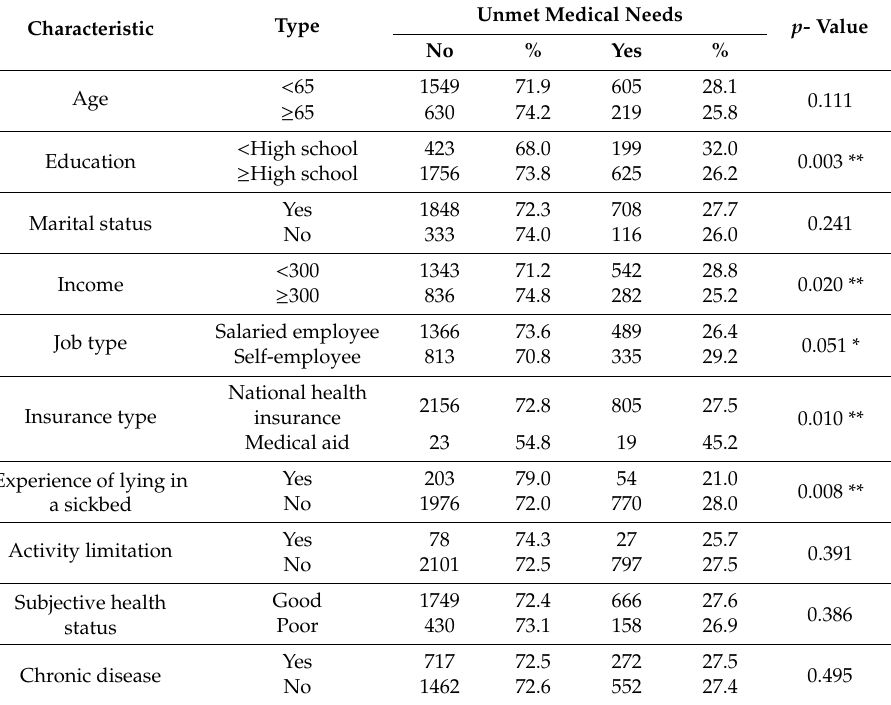
Table 2. Relationship between factors influencing medical services and unmet medical